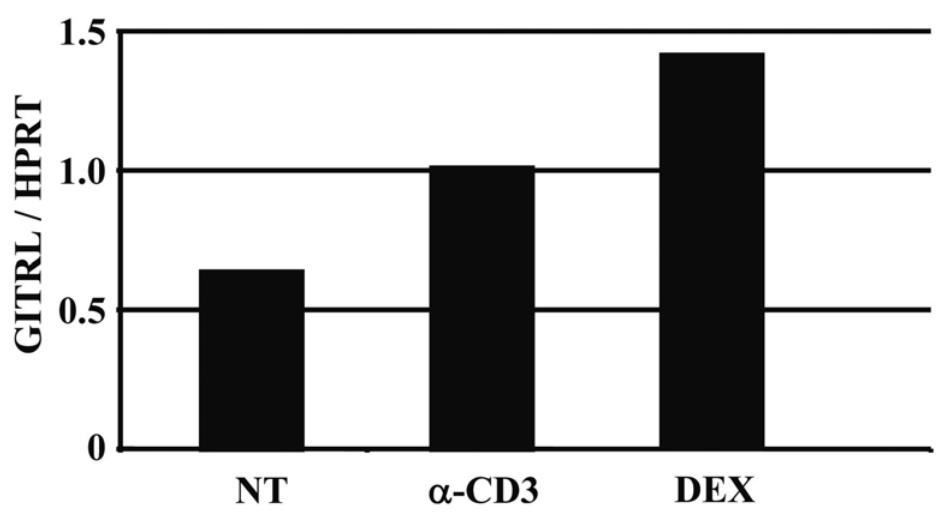
FIGURE 1. GITRL expression in T cells after triggering of TCR or treatment with glucocorticoids GITRL is upregulated on CD4 + T cells by TCR triggering ( α -CD3 antibody) or Dexamethasone treatment (DEX) as demonstrated by quantitative RT-PCR experiments. HPRT house keeping gene was used as control (unpublished